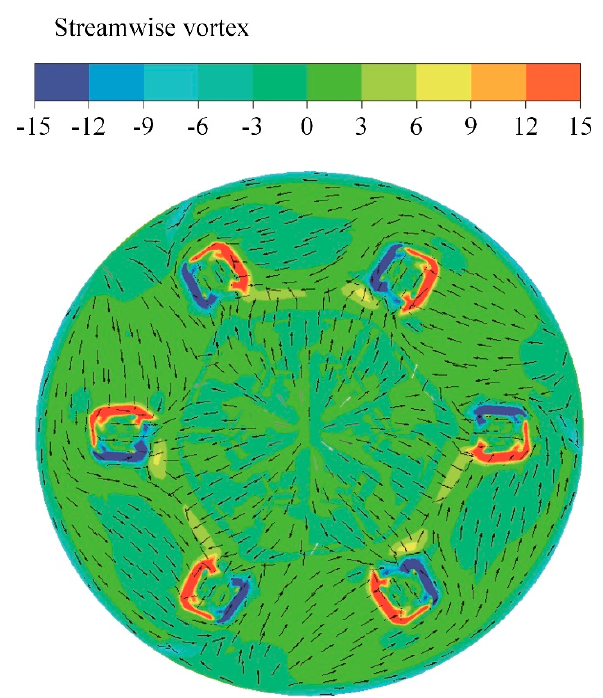
Figure 9. Streamwise vortex and velocity vector distribution at the exit of the square nozzle.